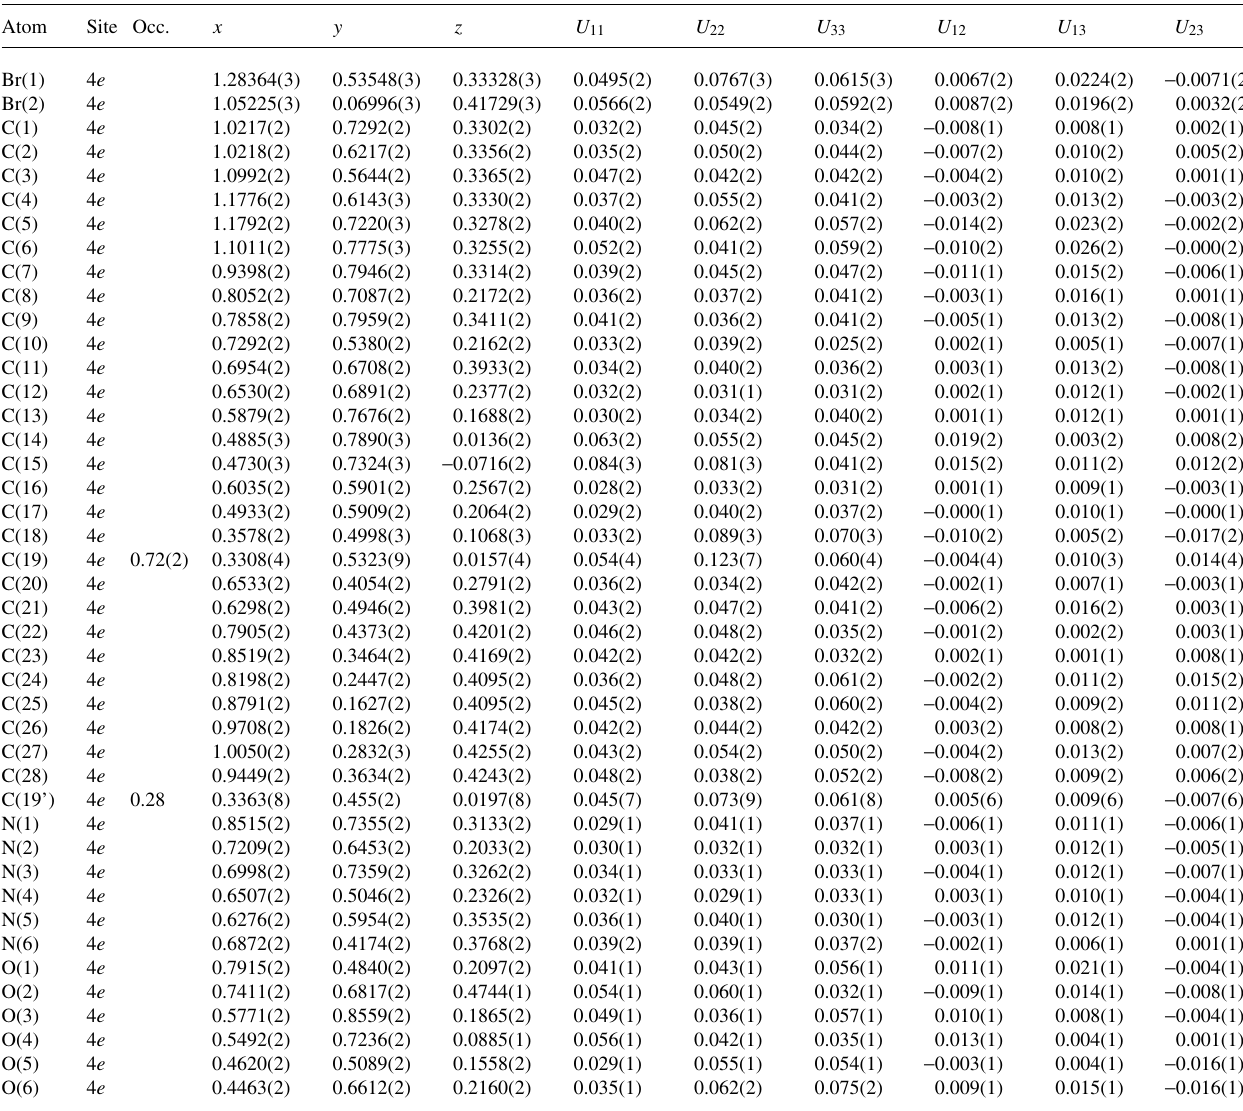
Table 3. Atomic coordinates and displacement parameters (in Å 2 ) .